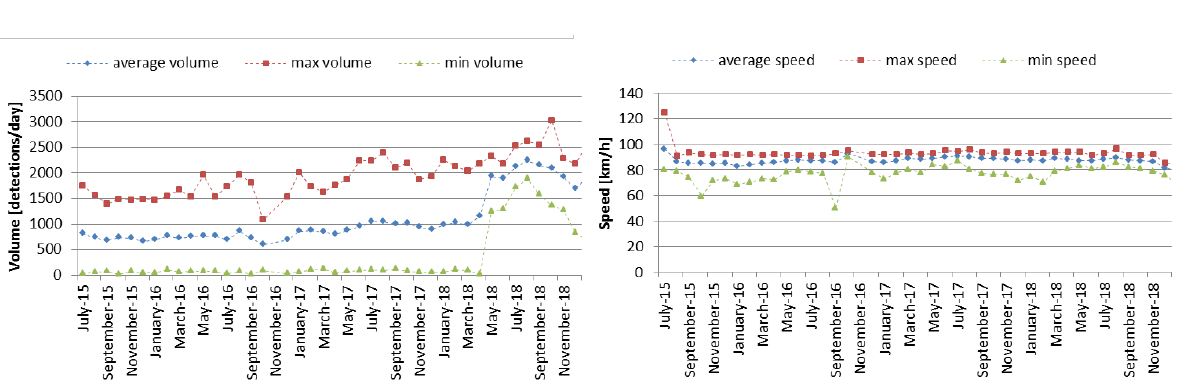
Figure 15: Number of detections and average speed for Route 2